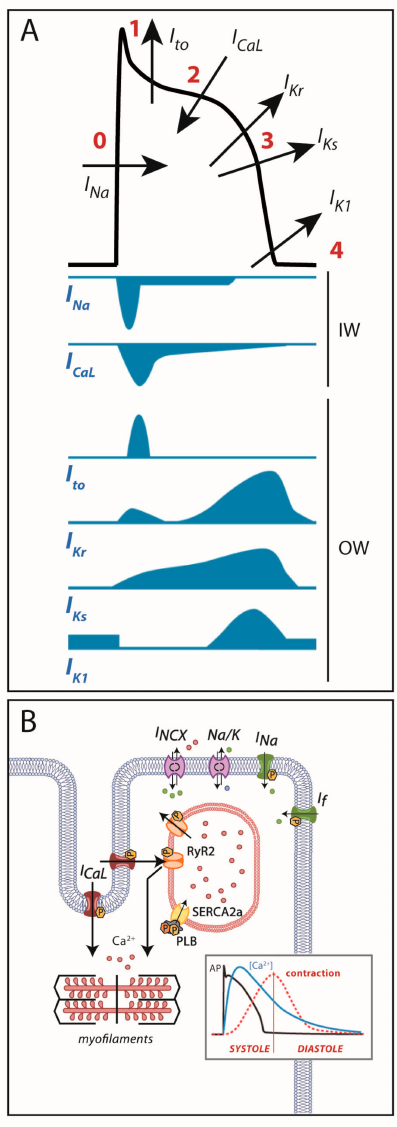
Figure 1. ( A ) Cardiac action potential and transmembrane ionic currents that participate in each phase. Phase 0: rapid depolarization due to entrance of Na + currents into the cell. Phase 1: early repolarization initiated by outward K + I to currents. Phase 2: a plateau phase marked by the Ca 2+ entry into the cell against K + outward repolarizing currents. Phase 3: end of repolarization produced by K + currents upon Ca 2+ channel-inactivation. Phase 4: resting membrane potential ( ≈− 90 mV) determined by inward-rectifier K + currents. OW: outward currents. IW: inward currents. ( B ) Excitation-contraction coupling: during action potential, Ca 2+ entry in phase 2 induces a large release of Ca 2+ from the sarcoplasmic reticulum through the RyR2 receptor that allows cell contraction. After repolarization, Ca 2+ is extruded from the cell through the Na + /Ca 2+ exchanger or taken back into the sarcoplasmic reticulum through SERCA2a to allow cell